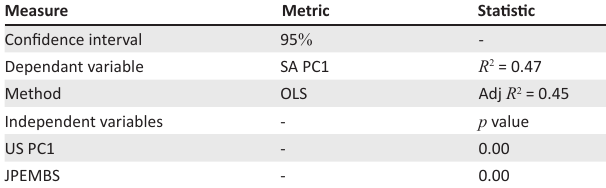
TABLE 7: Multivariate regression results: Sub-period